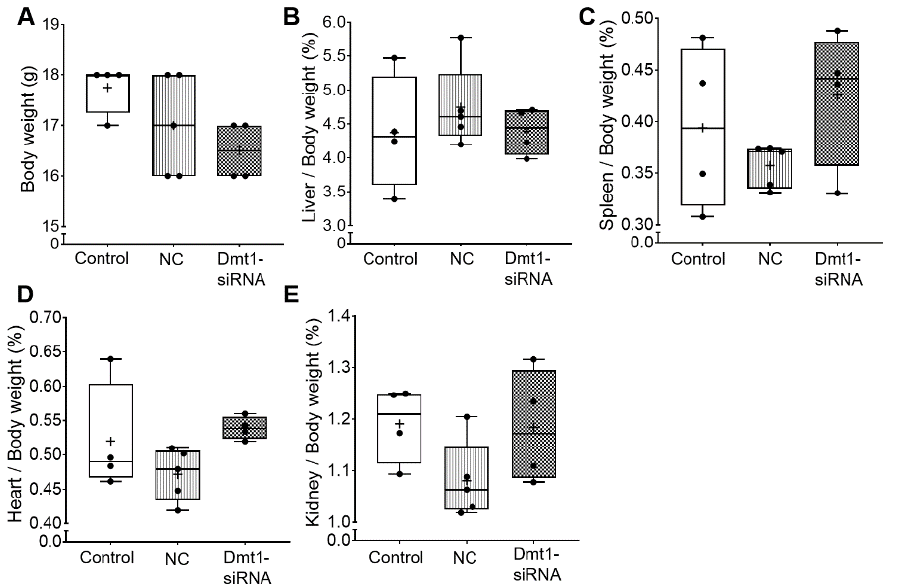
Figure 2. Body weight and tissue weights were not affected by FA-GDLV/siRNA treatments. Body weight ( A ), and relative liver ( B ), spleen ( C ), heart ( D ), and kidney ( E ) weights (as a percentage of total body weight) were quantified in experimental mice. Data are presented as box plots for n = 4–5 mice per group. No statistically significant differences were noted between groups (as determined by one-way ANOVA). NC, negative control. +, mean value.